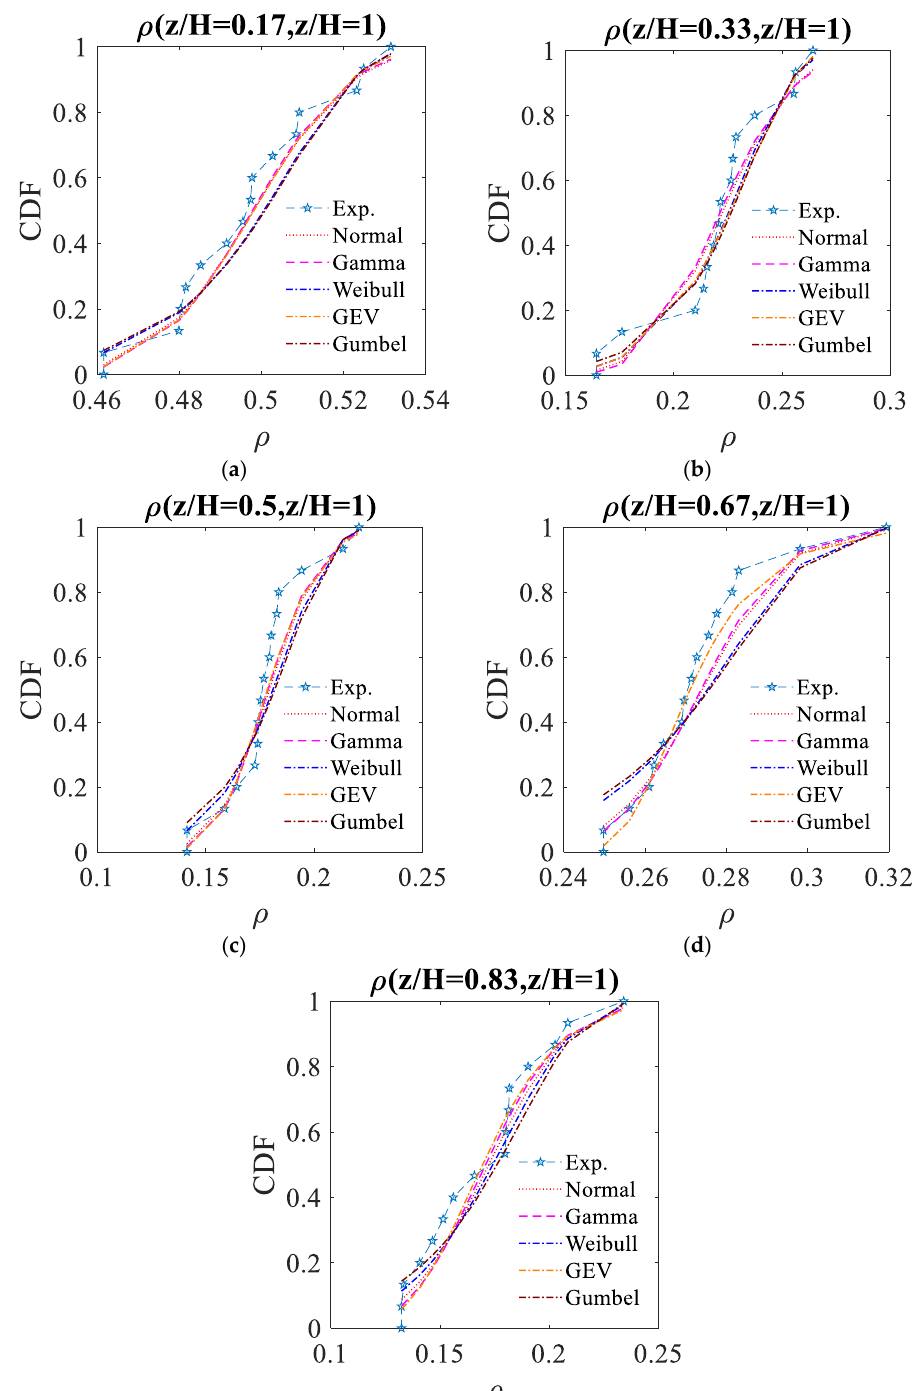
Figure 12. CDF of the correlation coefficient r between level #6 and the others, along wind, with 𝑈 = 49.0 m/s. ( a ) level #1 ( b ) level #2 ( c ) level #3; ( d ) level #4; and ( e ) level #5